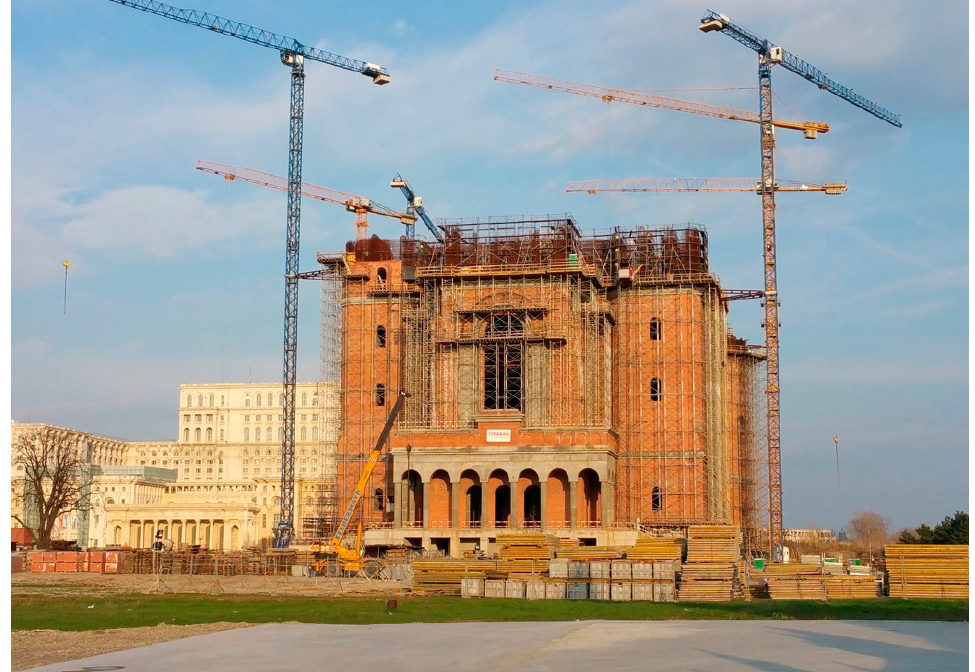
Figure 6. The construction of the gigantic People’s Salvation Cathedral in close vicinity of the Parliament Palace in Bucharest. Photo: Mirail Mihai, Creative Commons Attribution-Share Alike 4.0 International,